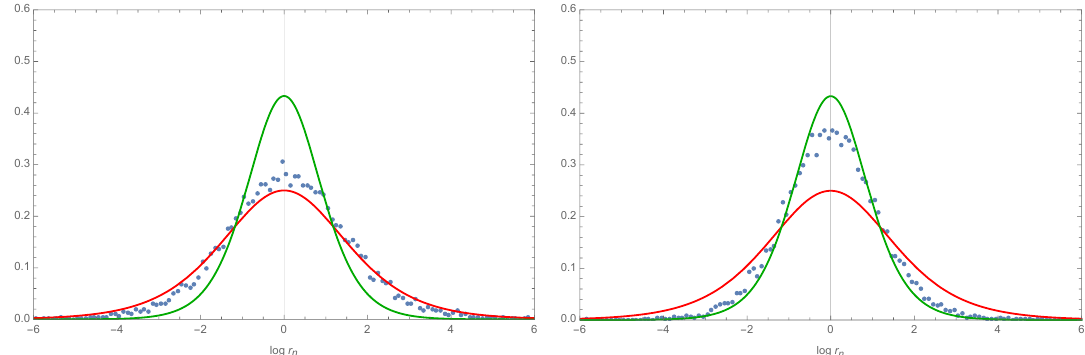
Figure 7. Distribution of log r n when (cid:0) = 0 : 1 for low lying states (left) and for states in the middle of the spectrum (right). The blue dots are numerical data, the red curve is the exponential distribution, and the green curve is the GOE ensemble prediction. There is a spin glass phase at low temperatures, and consequently the distribution is exponential. Since the spin glass phase is wiped out at high temperatures, the states from the middle of the spectrum follow GOE statistics.